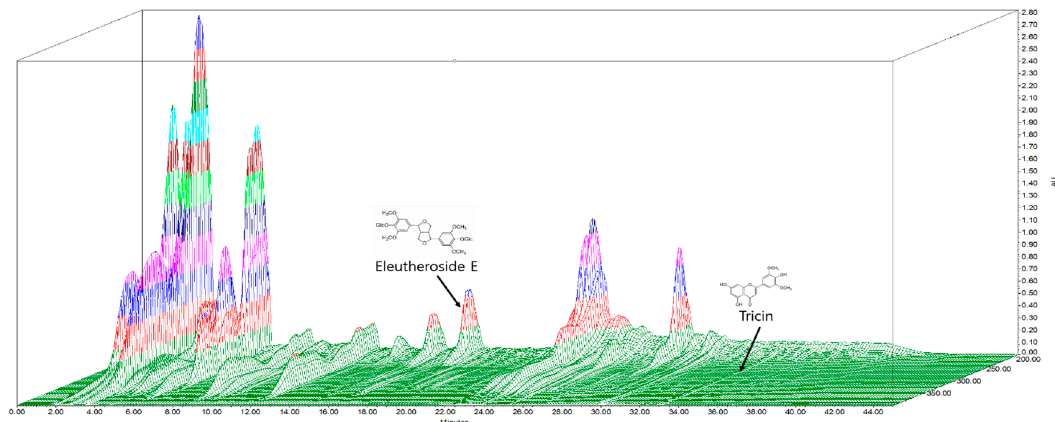
Figure 1. The three-dimensional high-performance chromatography of eleutherococcus extract mixture (EEM).